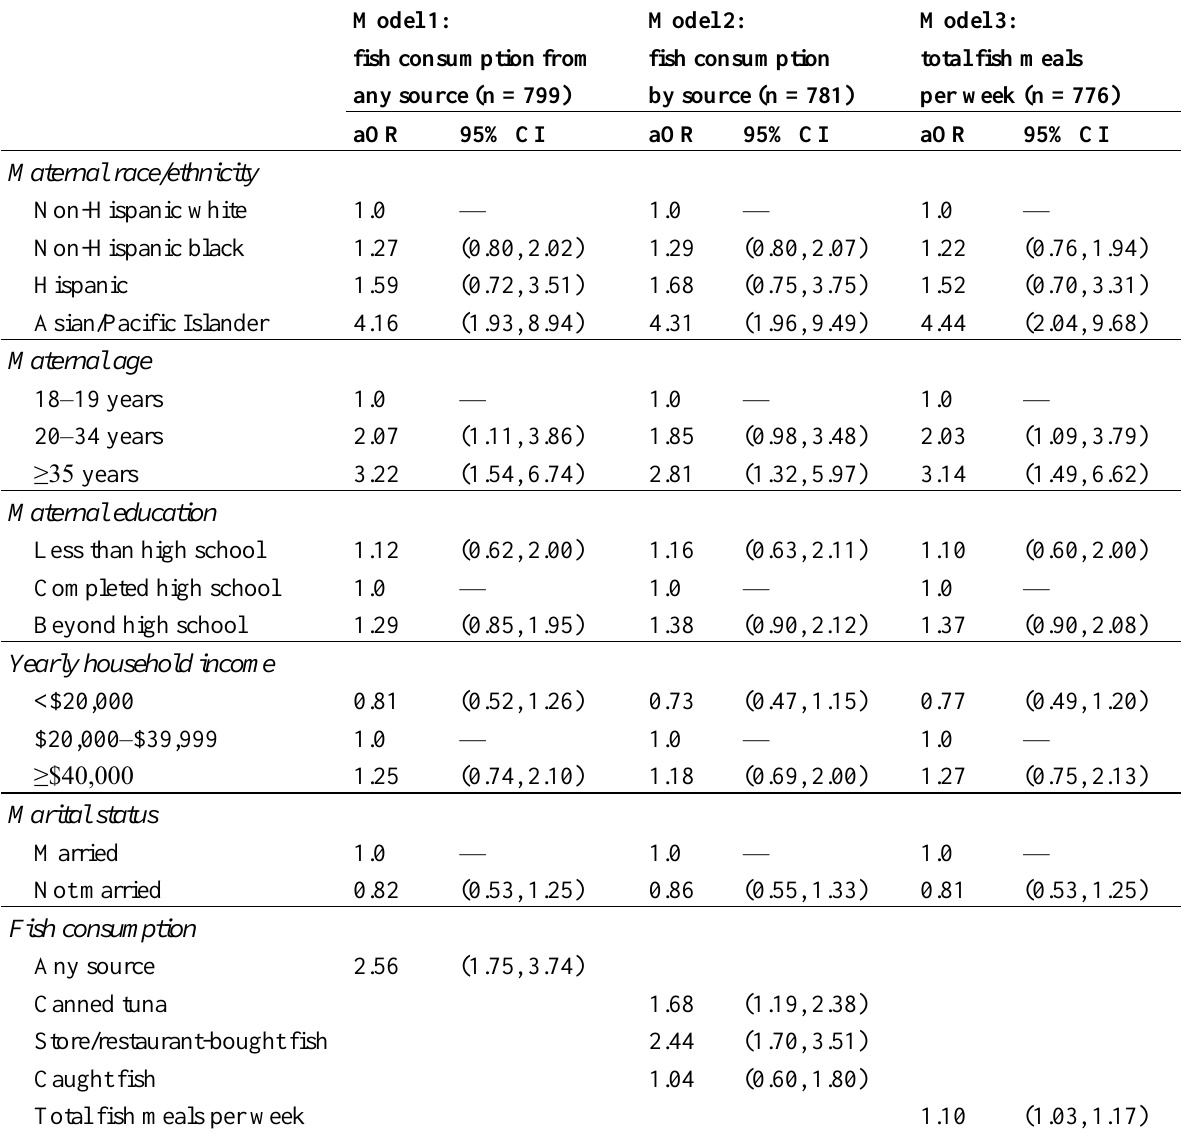
Table 4. Covariate-adjusted odds ratios and 95% confidence intervals from multivariate cumulative logistic models for blood mercury